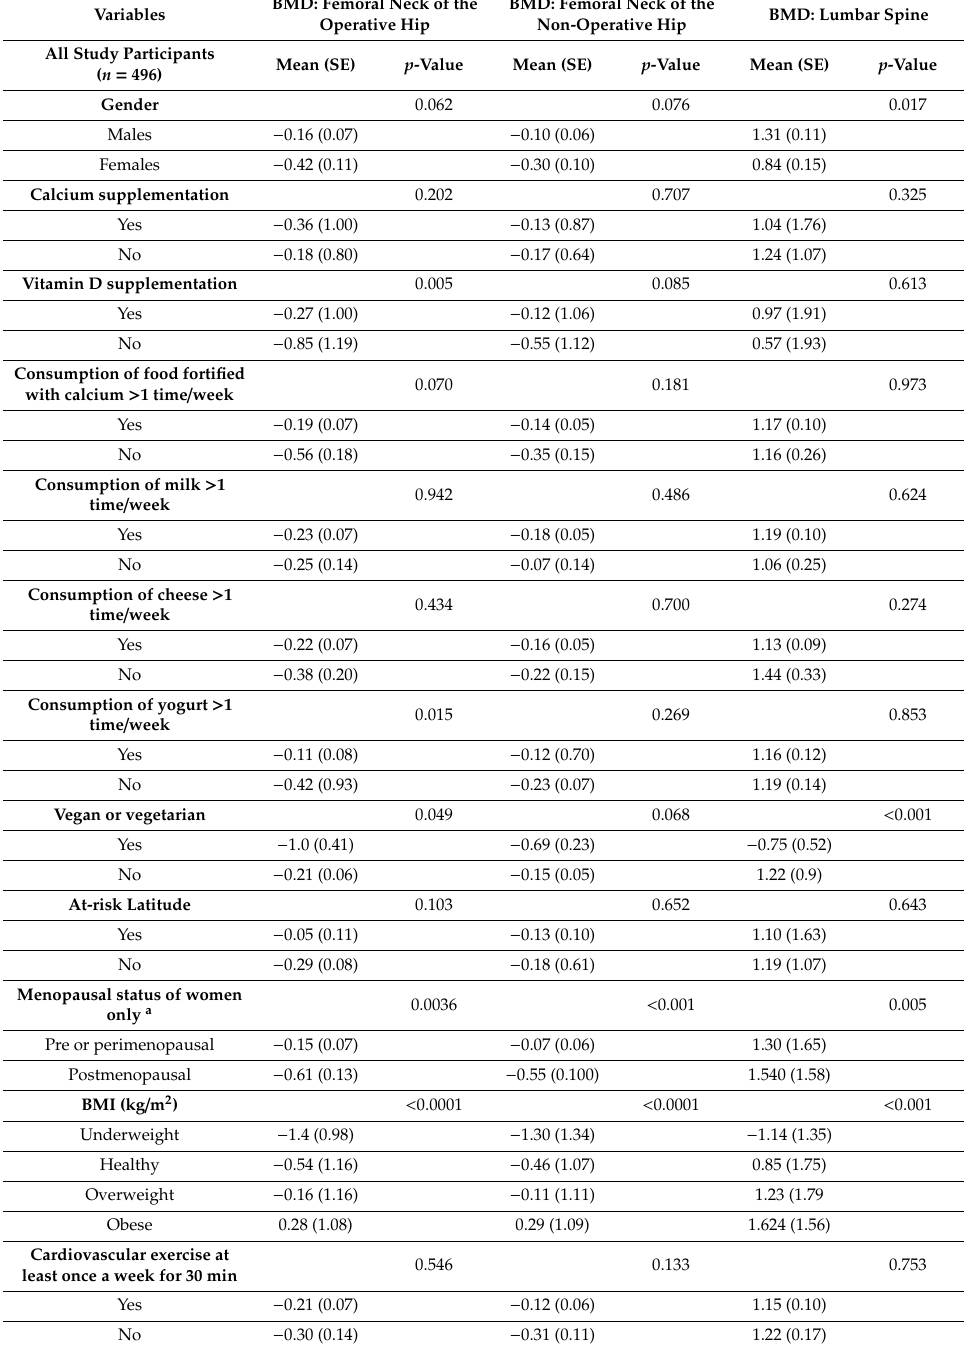
Table2. Di ff erencesinbonemineraldensity(BMD)t-scoresaccordingtodi ff erentindependentvariables. BMD: Femoral Neck of the BMD: Femoral Neck of the BMD: Lumbar Variables Operative Hip Non-Operative Hip